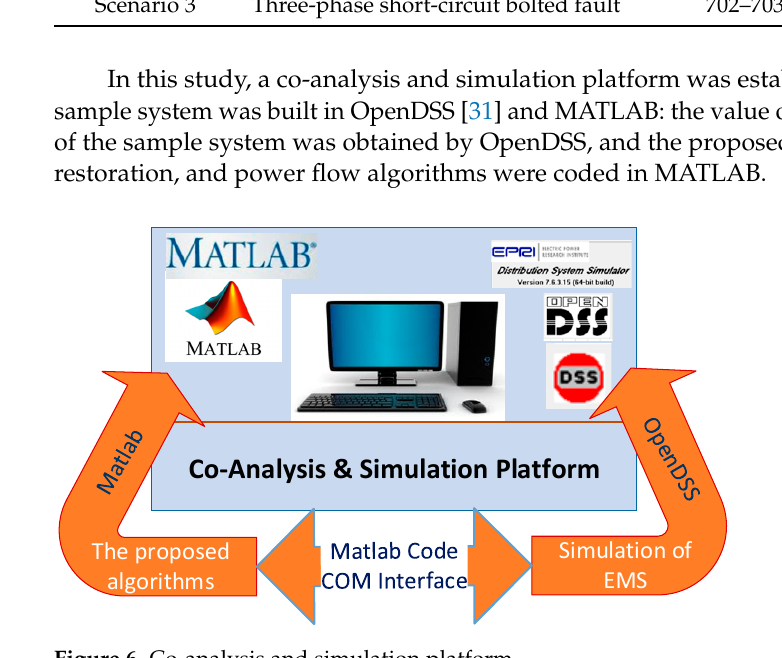
Figure 6. Co-analysis and simulation platform. Figure 6. C o-analysis and simulation platform. Table 1. Parameters of tie switches and lines.